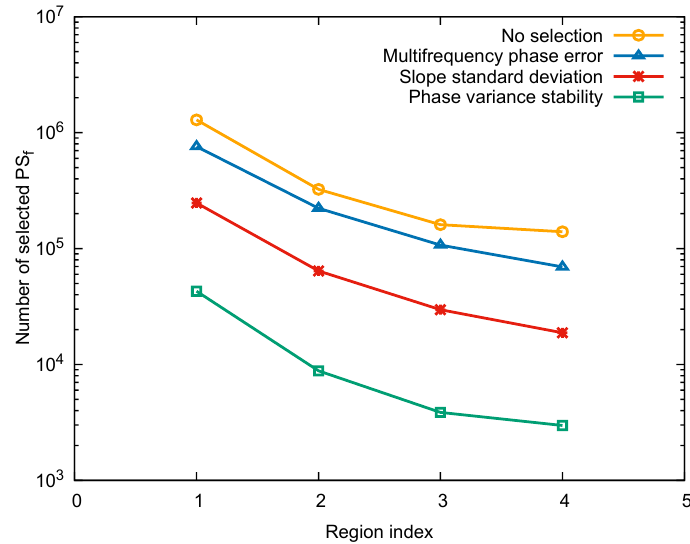
Figure 7. Number of selected PS f for regions 1 to 4 using the different detection criteria. The y -axis is on a logarithmic